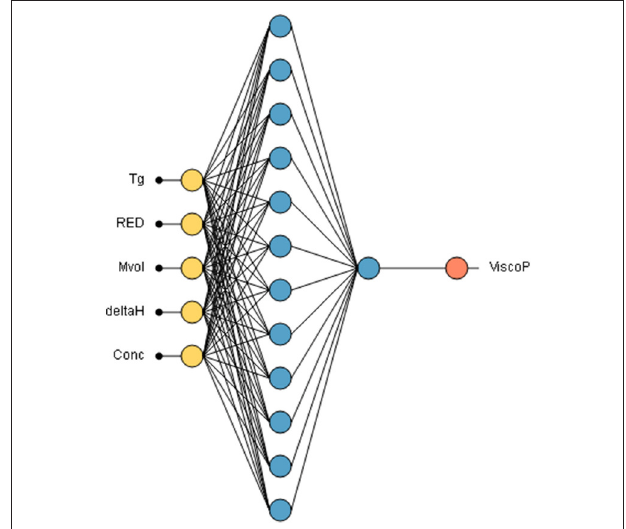
FIGURE 6 | Neural network used for unsaturated polyester resin viscosity prediction Input data are introduced through yellow neurons, the 12 learning neurons are represented in blue. One neuron in a second layer sum up linearly the outputs of the first layer. The orange neuron is the viscosity output